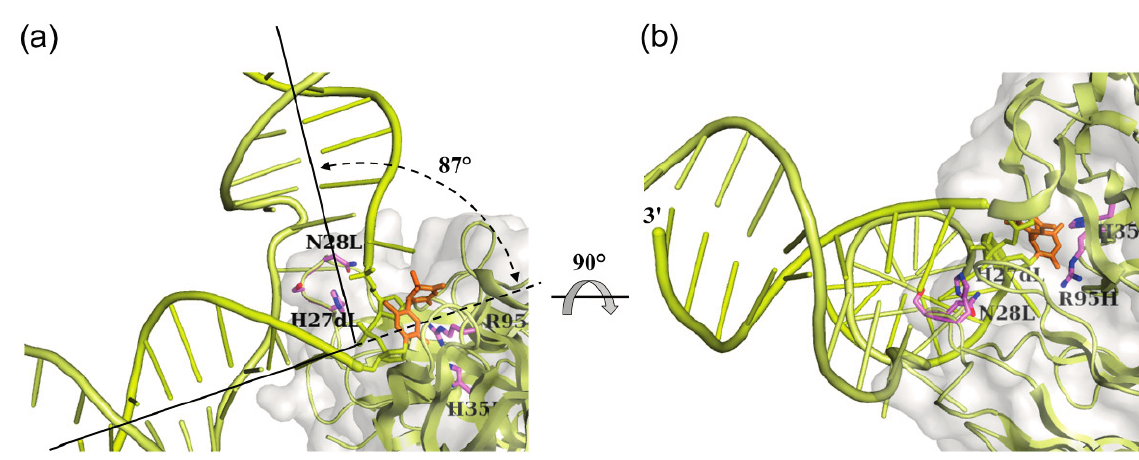
Figure 6. Structural differences in double-stranded (6-4) DNA in complex with the 64M-5 Fab, (6-4) photolyase, and the nucleotide excision repair protein DDB1-DDB2. DNAs are shown as cartoon models, and proteins are shown as cartoon and grey surface models. The T(6-4)T segments and some residues interacting with the T(6-4)T segments are shown as stick models. The complementary strand is shown in a paler color than the T(6-4)T-containing strand. The 3'-end of the T(6-4)T-containing strand is labeled as 3'. ( a , b ) Double-stranded (6-4) DNA in complex with the 64M-5 Fab (yellow). The base moiety of the T(6-4)T segment is colored orange. The view of ( b ) was almost the same as ( c ) and ( e ) if the T(6-4)T-containing strands were superposed between these structures; ( c ) Double-stranded (6-4) DNA in complex with the (6-4) photolyase (PDB ID: 3CVU, magenta). The base moiety of the T(6-4)T segment is colored red, and FAD is colored orange; ( d ) A close-up view of ( c ). Detailed interactions of the (6-4) photolyase (green) with the T(6-4)T nucleotide (magenta) are shown. Hydrogen bonds are shown in broken lines; ( e ) Double-standed (6-4) DNA in complex with the DDB1-DDB2 protein (PDB ID: 3EI1, cyan). The base moiety of the T(6-4)T segment is colored blue; and ( f ) A close-up view of ( e ). Detailed interactions of the DDB1-DDB2 protein (orange) with the T(6-4)T nucleotide (cyan) are shown. (Reproduced and slightly modified from reference [14] with the permission of the International Union of